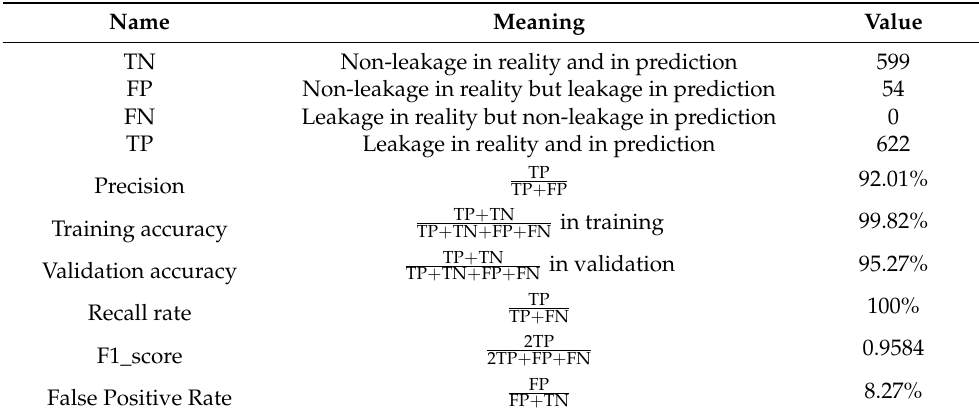
Table 1. Indicators to evaluate the Random Forest